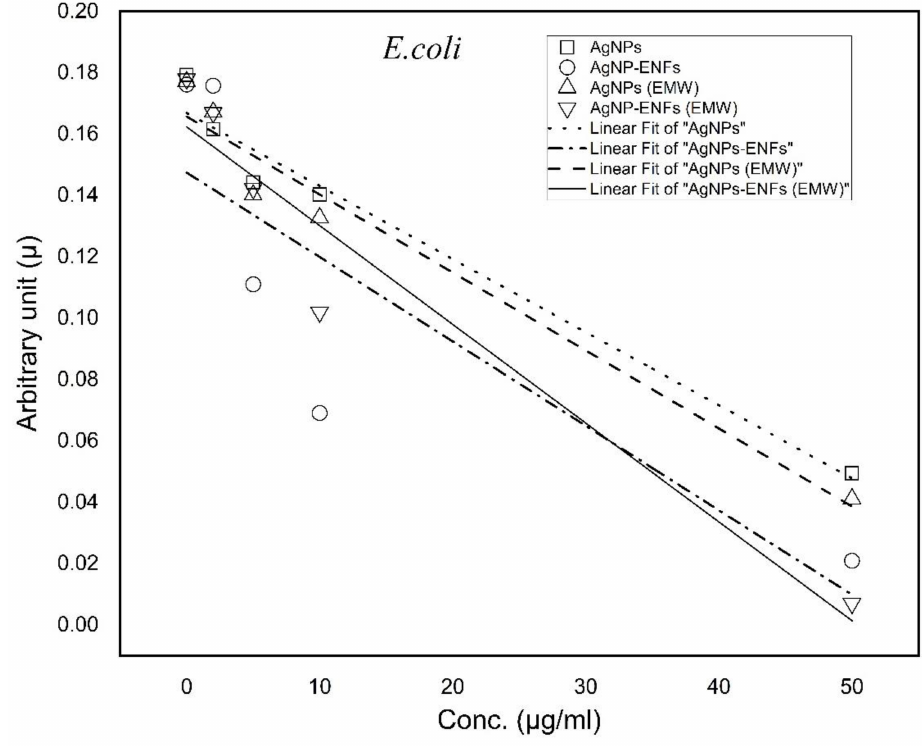
Figure 9. Trend lines of arbitrary constant values for E. coli under each treatment condition at different Ag NPs concentrations.